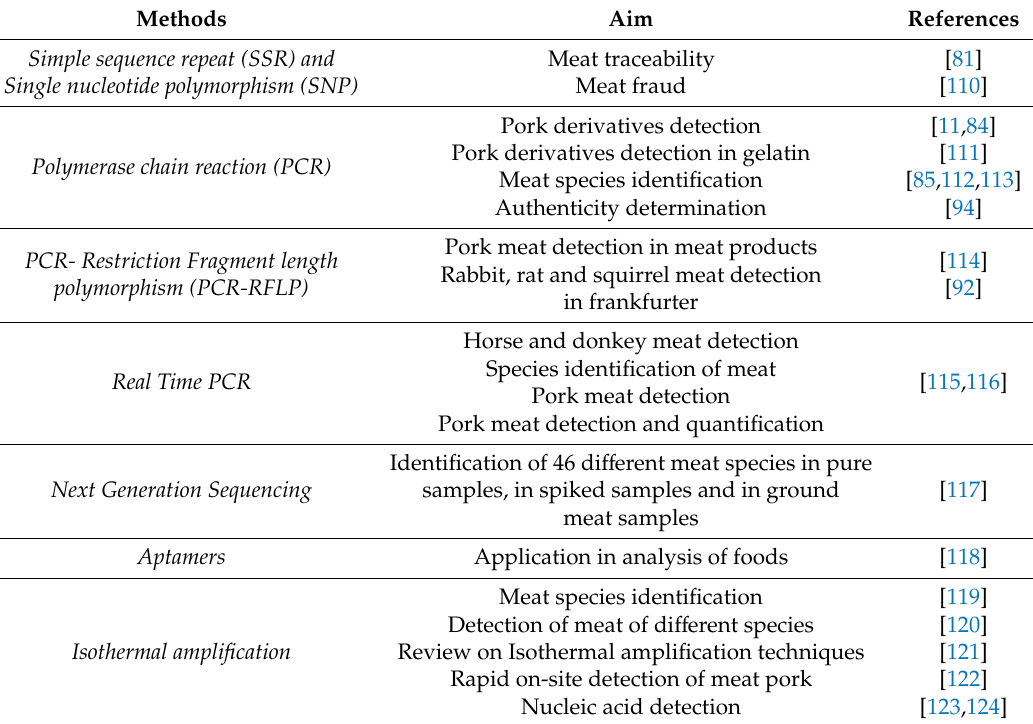
Table 3. Examples of genetic methods for h.al¯al authenticity